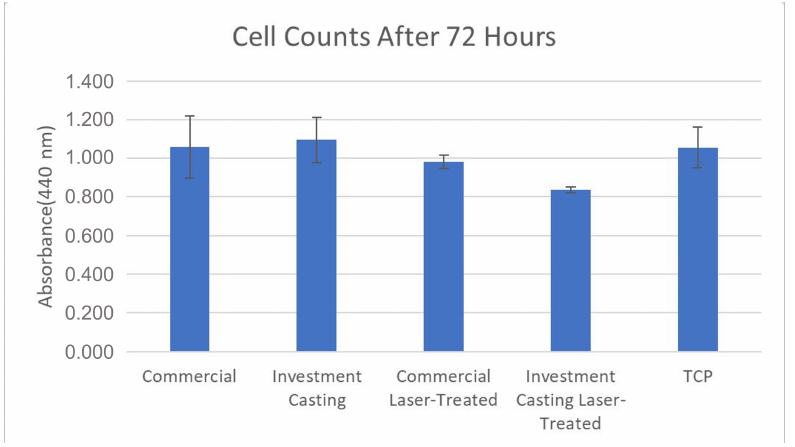
Figure 11. Number of viable cells at the end of 72 h according to absorbance values with a wavelength of 440